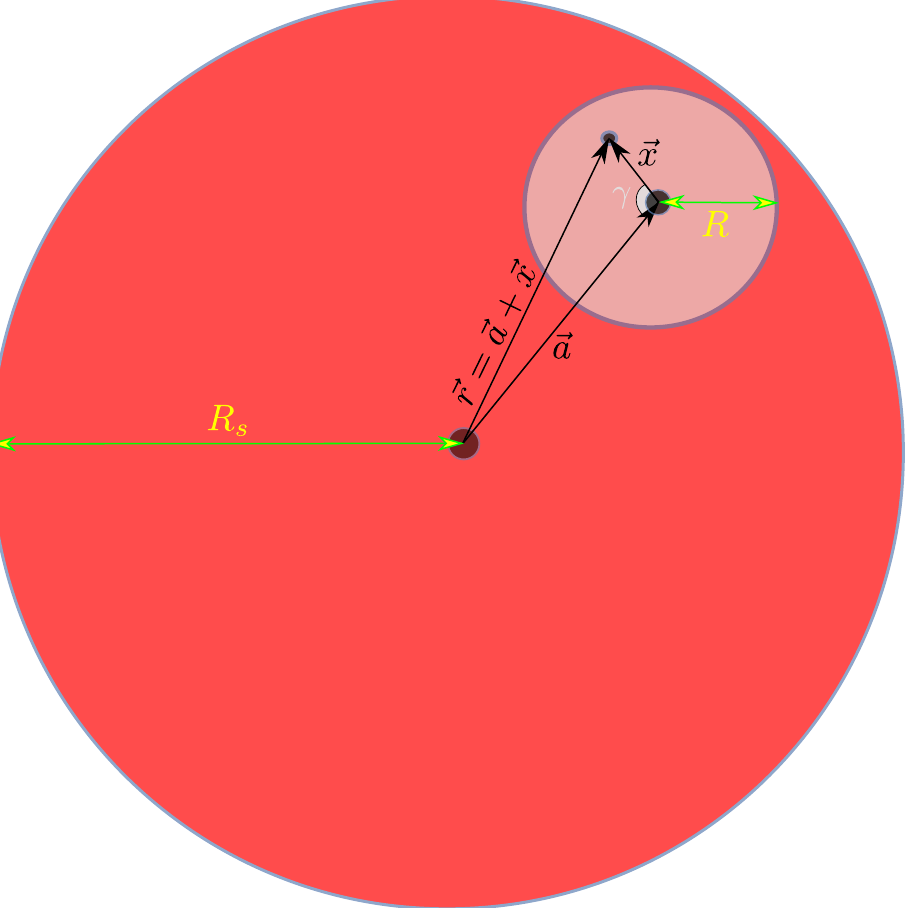
Figure 4 . An illustration of an ASt passing through an ordinary star. The relative radii of the ASt ( R ) and the star ( R s ) are not to